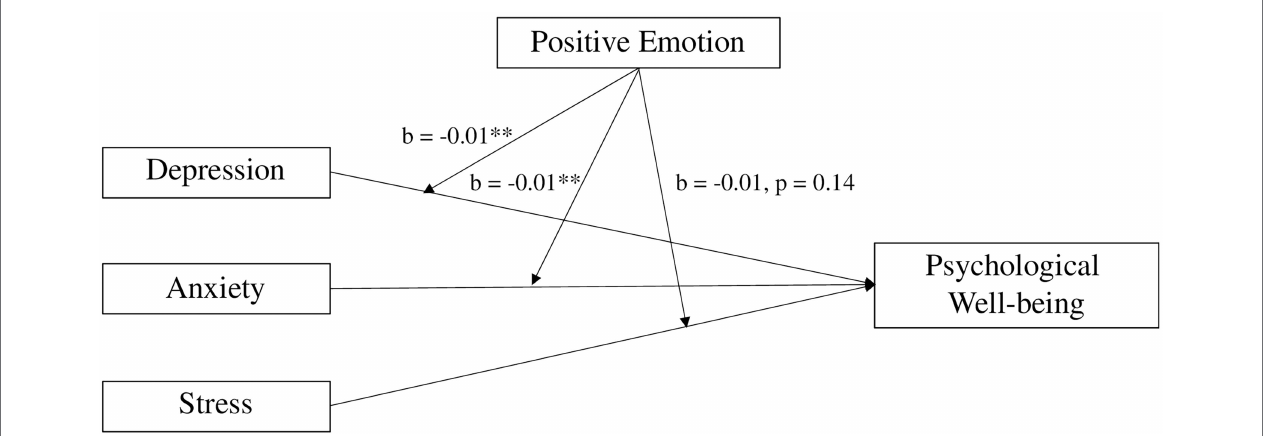
FIGURE 2 | Positive emotion moderates the effect of the psychological outcomes (depression, anxiety, and stress) on psychological wellbeing. Note: ** p <